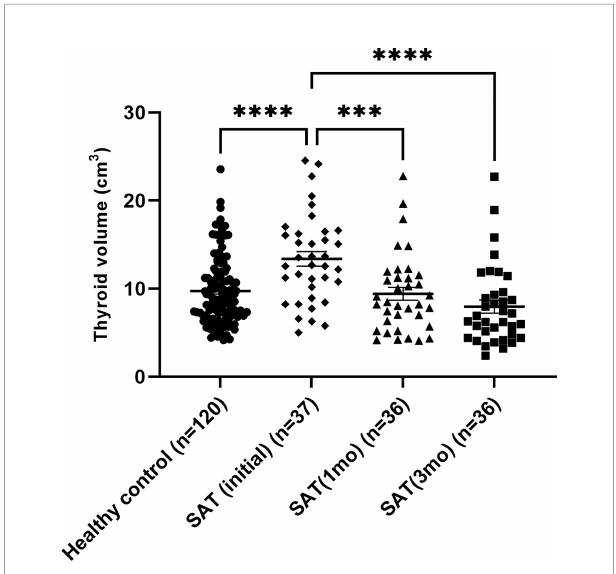
FIGURE 1 | Time-varying thyroid volumes of subacute thyroiditis patients compared with those of healthy controls. *** P ≤ 0.001, **** P ≤